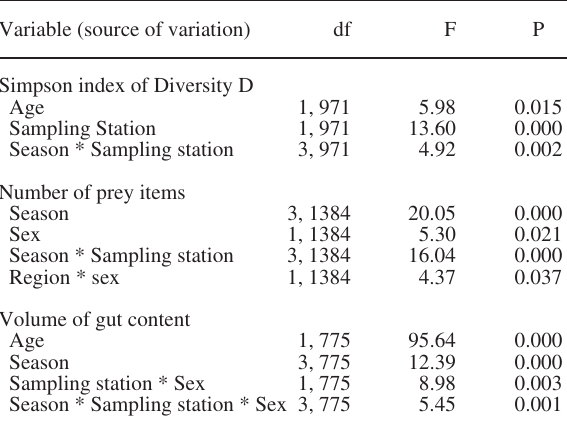
Table 2. – anCoVa results of the dietary descriptors of Aphanius fasciatus Variable (source of